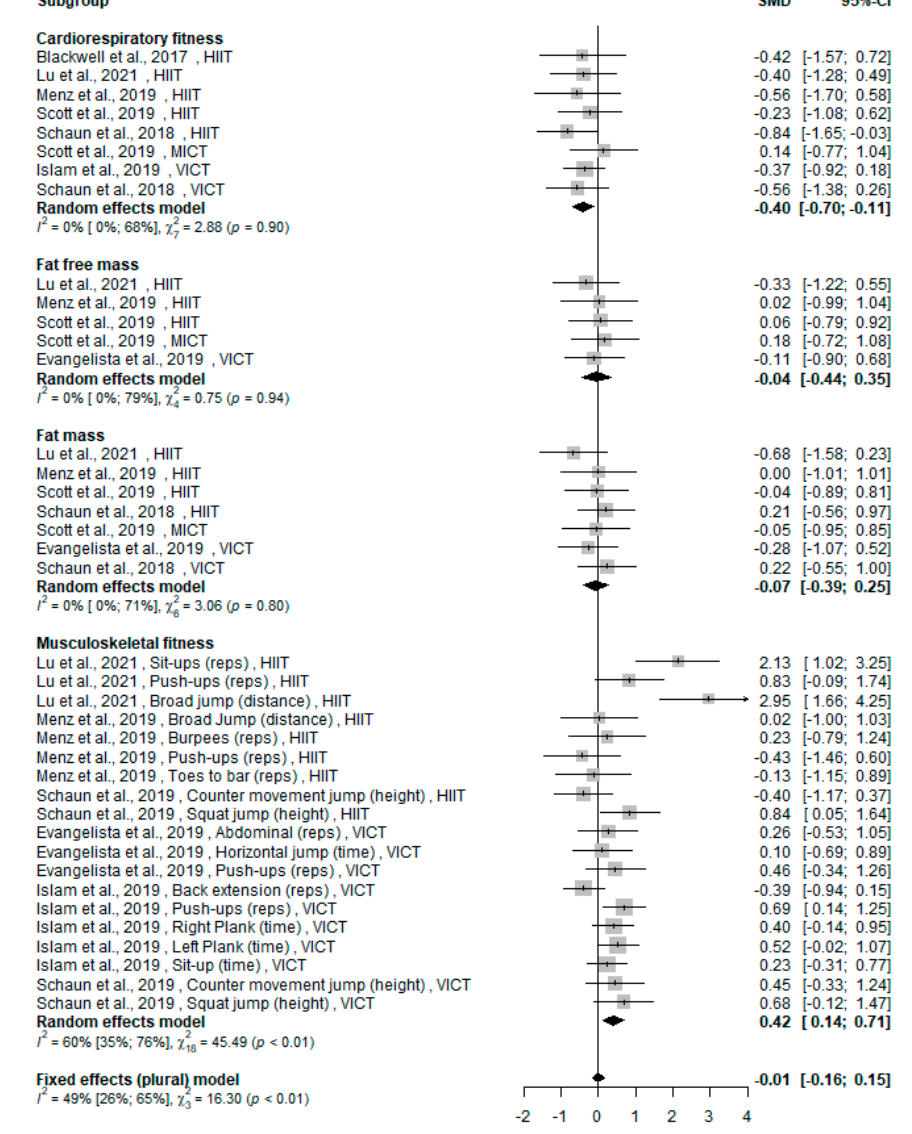
Figure 3. Forest plot of standardized mean difference (SMD) and confidence interval (CI) for the comparison WB-HIIT vs. traditional aerobic training. Positive values favor WB-HIIT. Subgroups mean effect and overall effect are written in bold. HIIT, high-intensity interval training; MICT, moderate-intensity continuous training; VICT, vigorous-intensity continuous training; Reps, number of repetitions performed during a certain amount of time or until exhaustion.